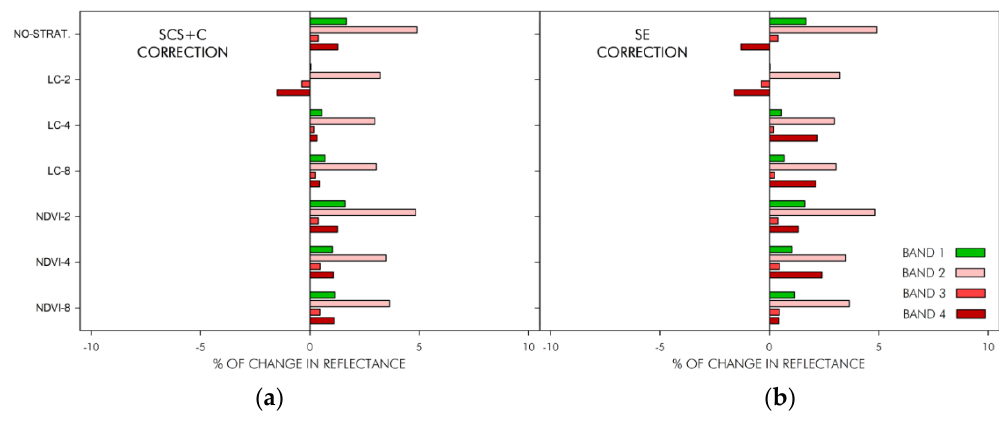
Figure 8. Radiometric stability of land covers represented by the area-weighted average of % change in land cover reflectance after SCS+C correction ( a ) and SE correction ( b ).